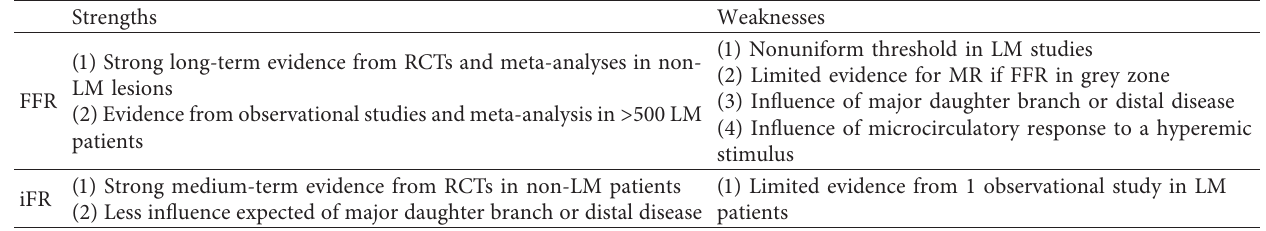
Table 2: Main strengths and weaknesses of FFR and iFR in LM revascularization decision making. Strengths Weaknesses FFR